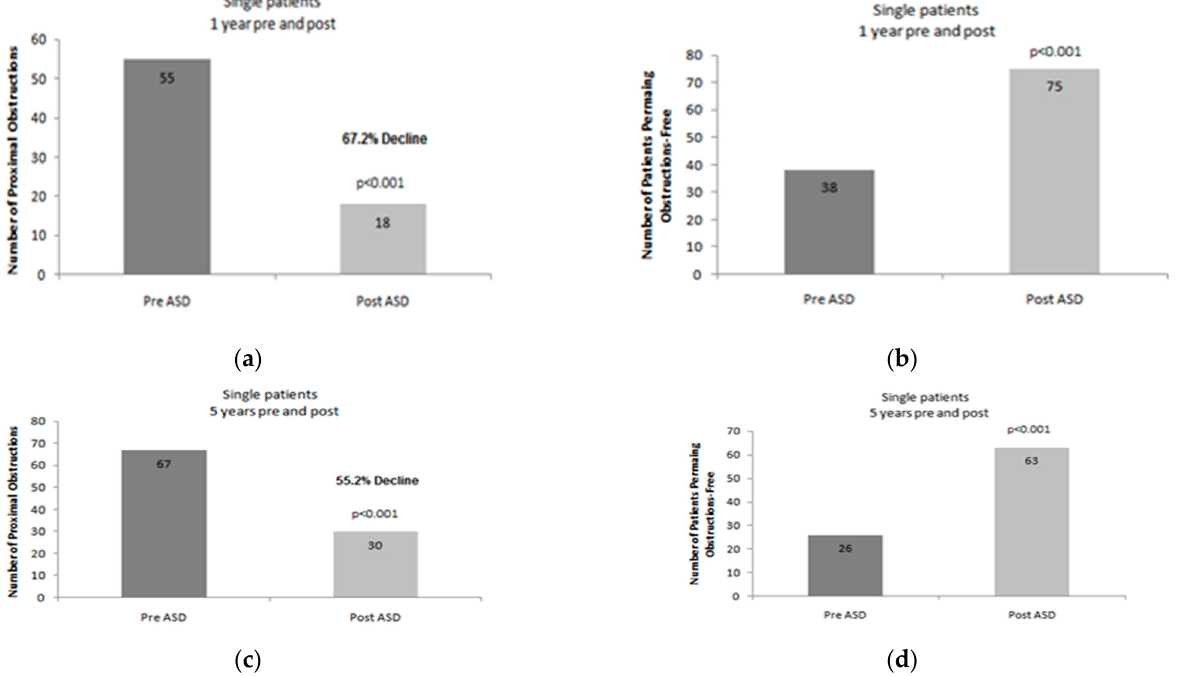
Figure 1. Proximal shunt revision rates after ASD placement in “simple” patients. ( a ): Graphical illustration of the 1-year number of proximal shunt revisions after ASD implantation in “simple” shunt patients. ( b ): Graphical illustration of the number of patients with no proximal shunt obstruction during the study period (1-year). ( c ): Graphical illustration of the 5-year number of proximal shunt revisions after ASD implantation in “simple” shunt patients. ( d ): Graphical illustration of the number of patients with no proximal shunt obstruction during the study period (5-years).